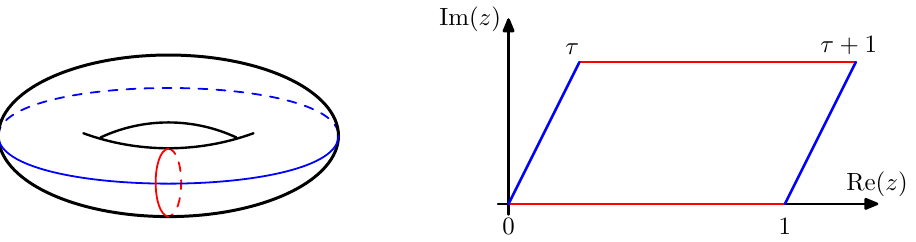
Figure 2 . Parametrization of a torus as a lattice C = ( Z + (cid:28) Z ) with modular parameter (cid:28) in the upper half plane and complex coordinate z (cid:24) = z +1 (cid:24) = z + (cid:28) . The homology cycle drawn in red is mapped to the unit interval (0 ; 1) and referred to as the A -cycle. Accordingly, the second homology cycle mapped to the path from 0 to (cid:28) is known as the B